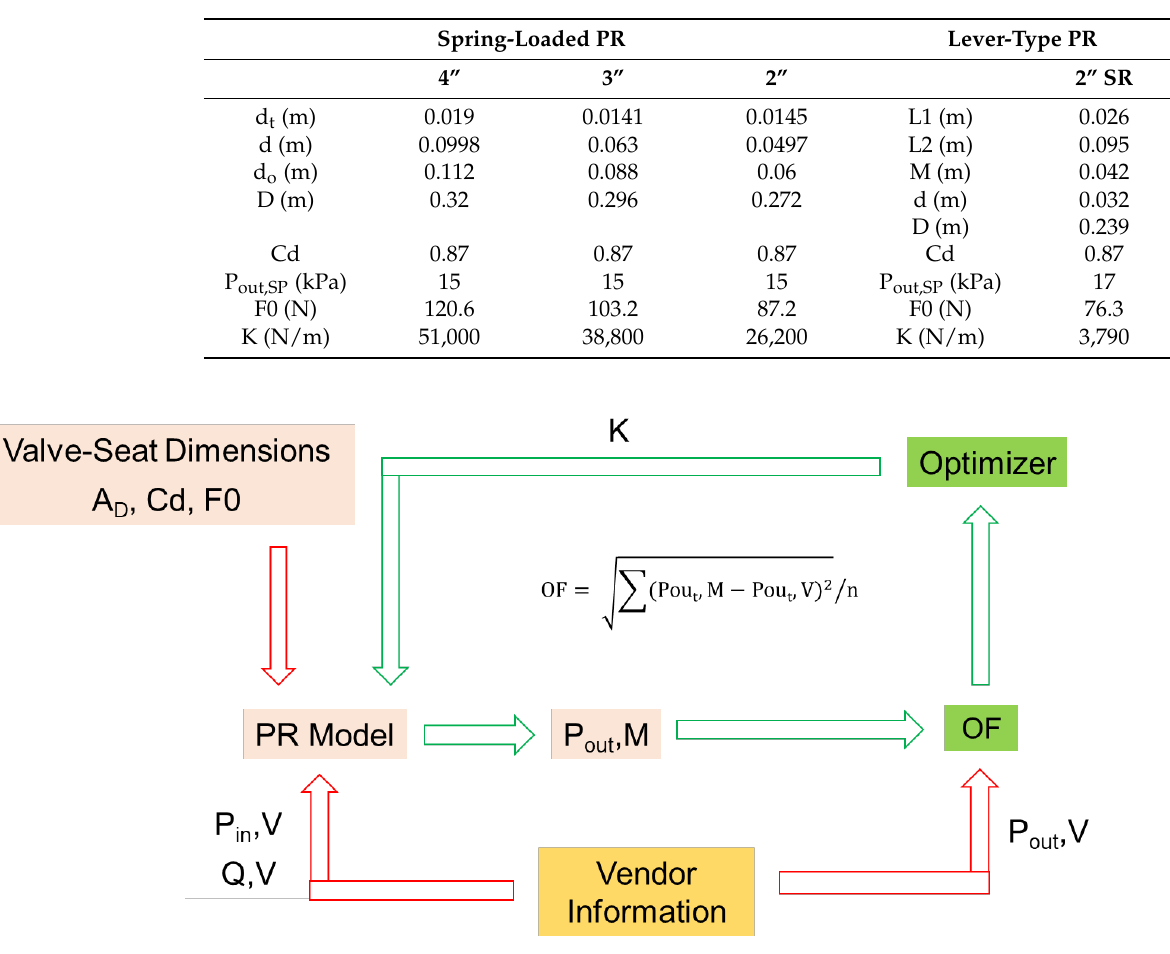
Figure 4. The optimization-based methodology that was used to estimate the K values using vendor data.